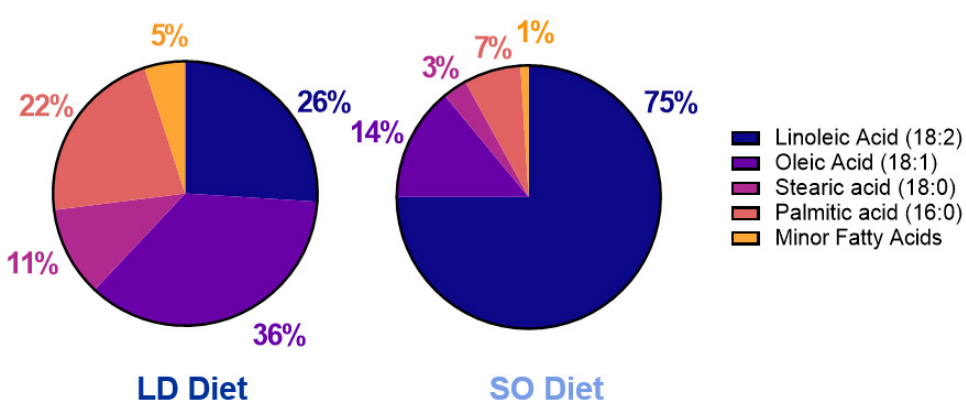
Figure 1. Fatty acid composition of the fat sources used for LD and SO diets. Dietary oils (n = 3 samples/group) were analyzed by gas chromatography and expressed as a percent of total fatty acids. All samples have a coefficient of variation of <3% between experimental replicates.